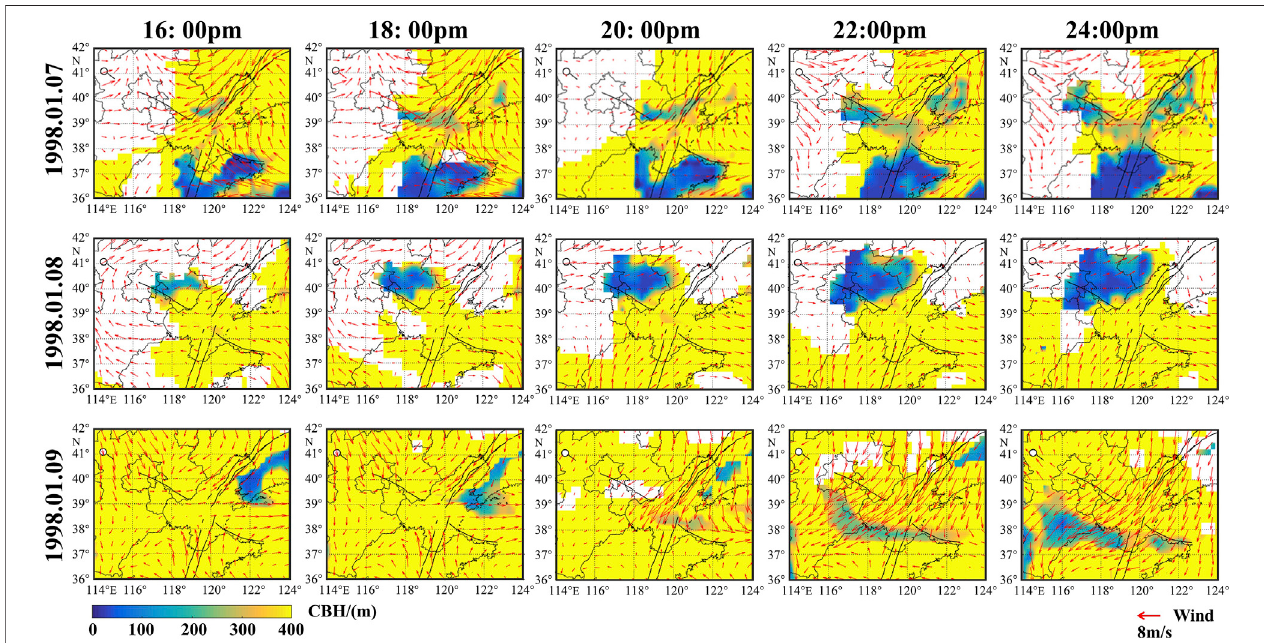
FIGURE 10 | Cloud bottom height and wind fi eld from 7 – 9 January